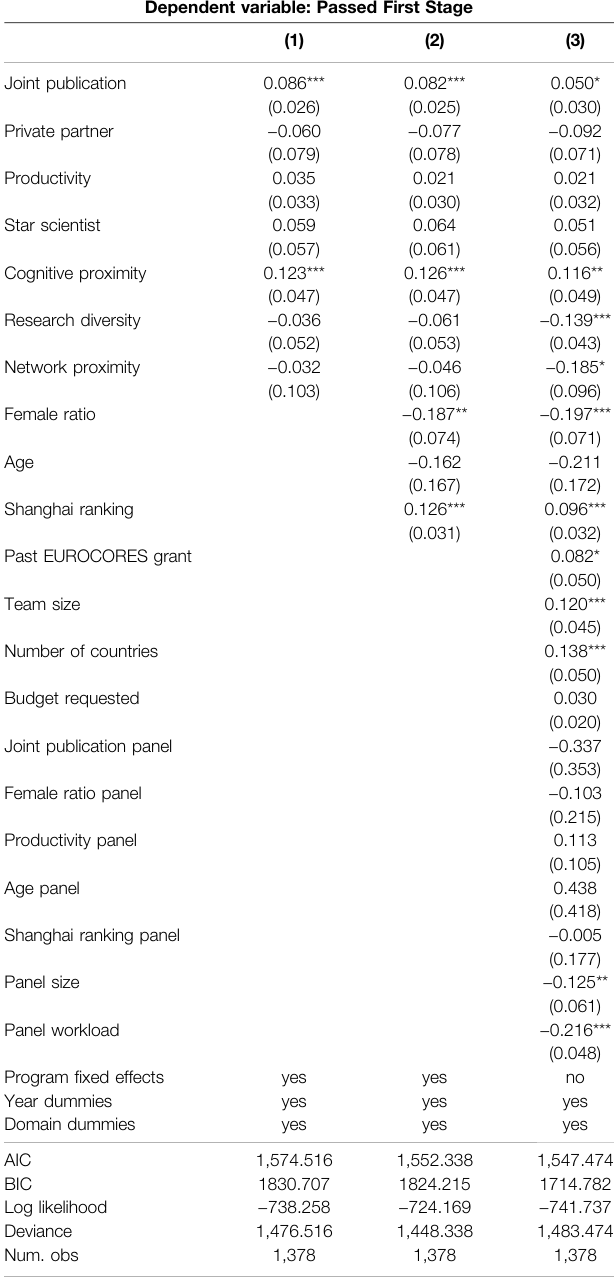
TABLE 8 | First Stage — Probit regression results. Dependent variable: Passed First